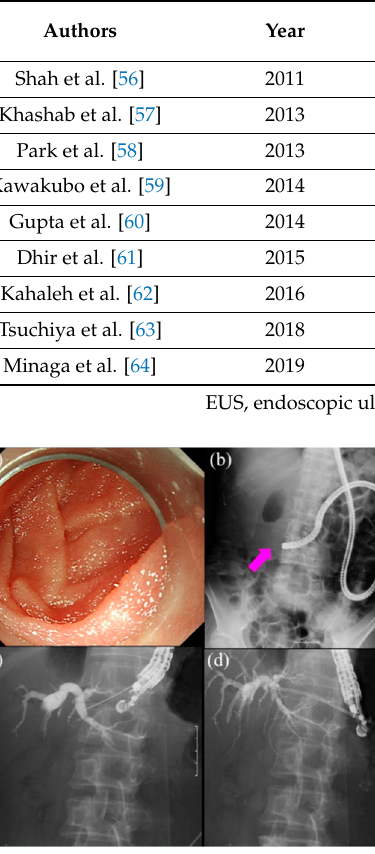
Figure 4. Endoscopic ultrasound-guided hepaticogastrostomy for patients with surgically altered anatomy (SAA) showing a failed case of single-balloon enteroscopy-assisted (SBE) endoscopic retrograde cholangiopancreatography (ERCP). ( a ) It was impossible to reach the papilla due to cancer invasion of the duodenum. ( b ) Fluoroscopic image showing duodenal obstruction due to cancer invasion (pink arrow). ( c ) Endoscopic ultrasound-guided hepaticogastrostomy is performed. First, B 3 is punctured using a 19-gauge needle. After puncture, we performed cholangiography to confirm the position of the guidewire. ( d ) Finally, a biliary stent was placed.